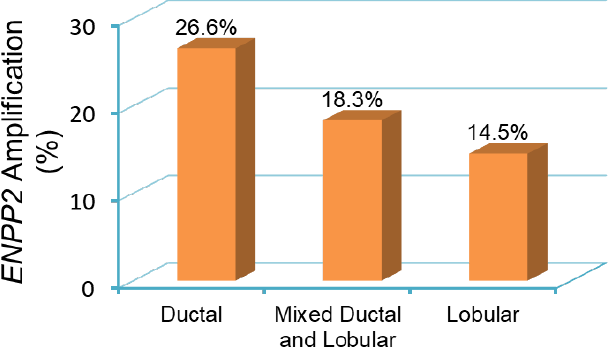
Figure 4. ENPP2 amplification in primary breast tumor samples from patients [92]. Breast tumor samples are categorized as ductal, lobular, and mixed ductal and lobular carcinoma. The incidence of ENPP2 amplification is 26.6% in ductal (441 out of 1660 cases), 18.3% in mixed ductal and lobular (40 out of 218 cases), and 14.5% in lobular (25 out of 172 cases) breast carcinomas. Data is obtained and analyzed from cBioPortal (www.cbioportal.org) [86,87].